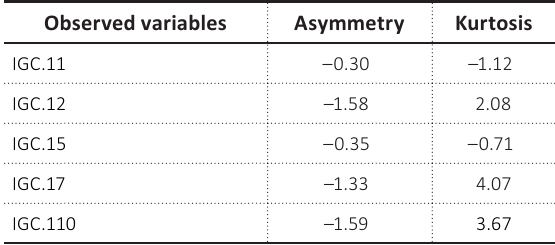
Table 3. Univariate normality test – skewness and kurtosis